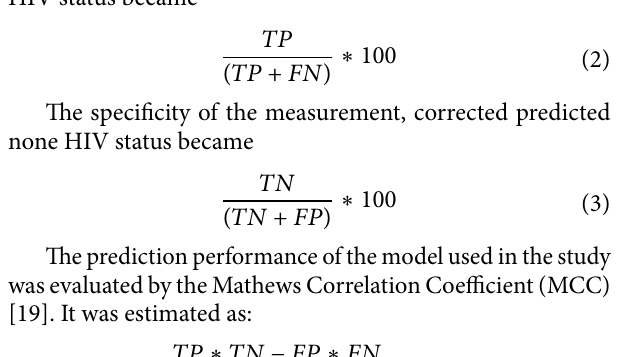
Table 2: Prediction results of the random forest method (confusion matrix) in the present